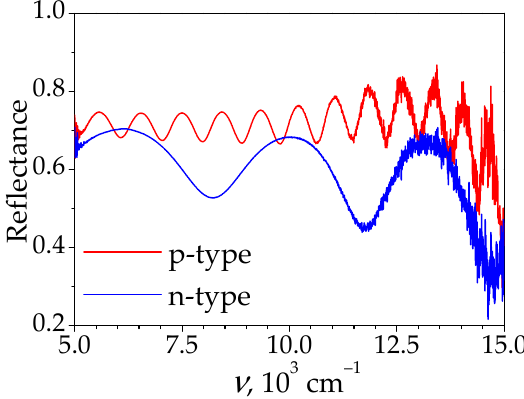
Figure 1. Reflectance spectra of unmodified a-Si films. Table 1. Sample preparation parameters and formed LIPSS periods.